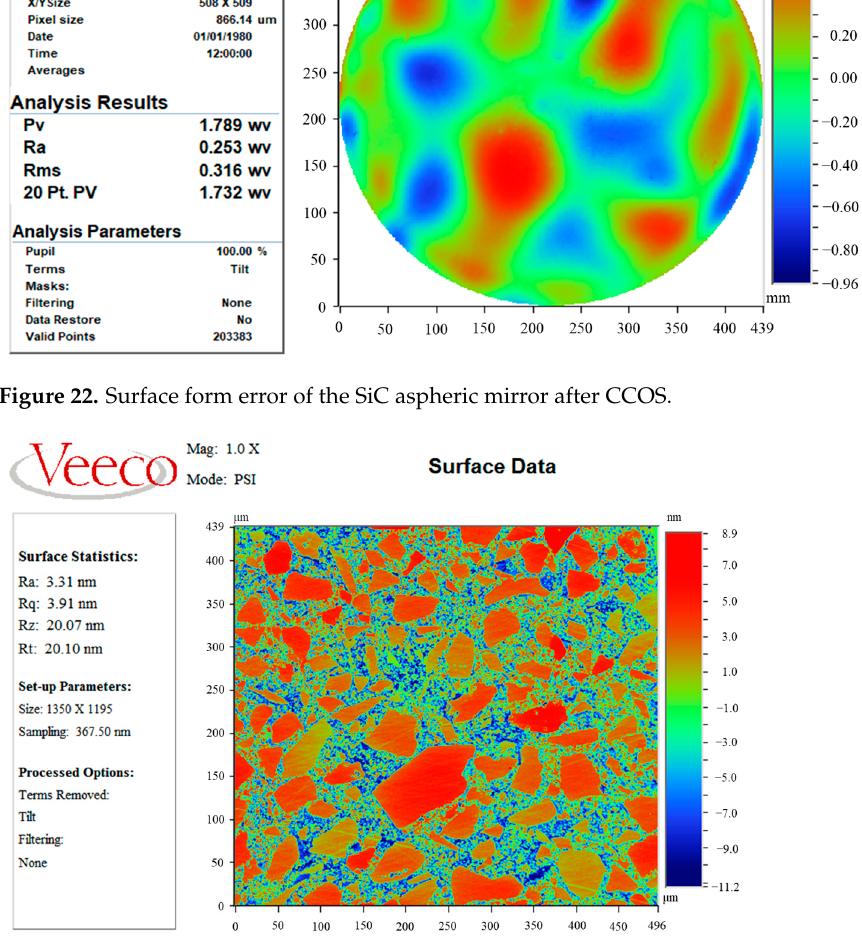
Figure 23. Roughness of the SiC aspheric mirror after CCOS.